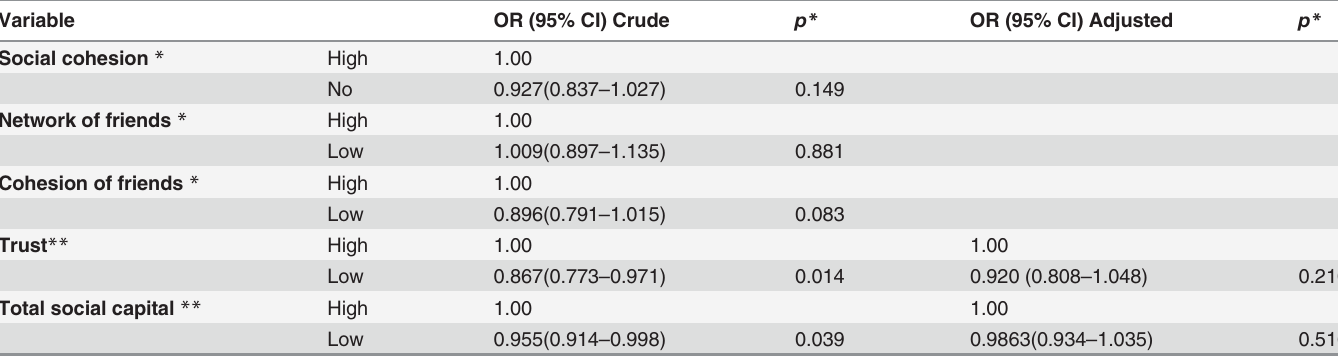
Table 2. Results of univariate logistic regression in exploratory analysis of social capital among 588 12-year-old students, Brazil, 2014.